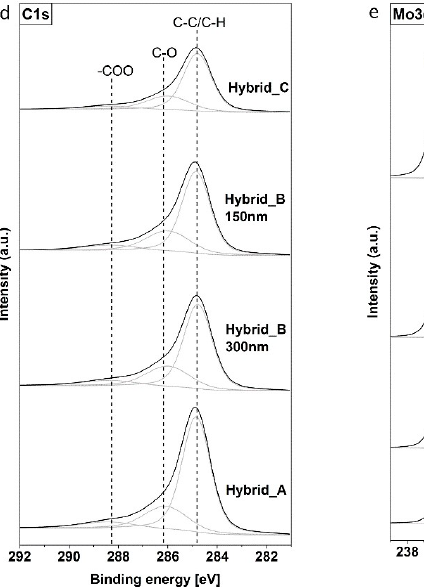
Figure 2. X-ray photoelectron spectroscopy (XPS) spectra: C 1 s of diamond-like carbon (DLC) coatings ( a ) and hybrid coatings ( d ); Mo 3 d of MoS 2 coatings ( b ) and hybrid coatings ( e ); S 2 p of MoS 2 coatings ( c ) and hybrid coatings ( f ).